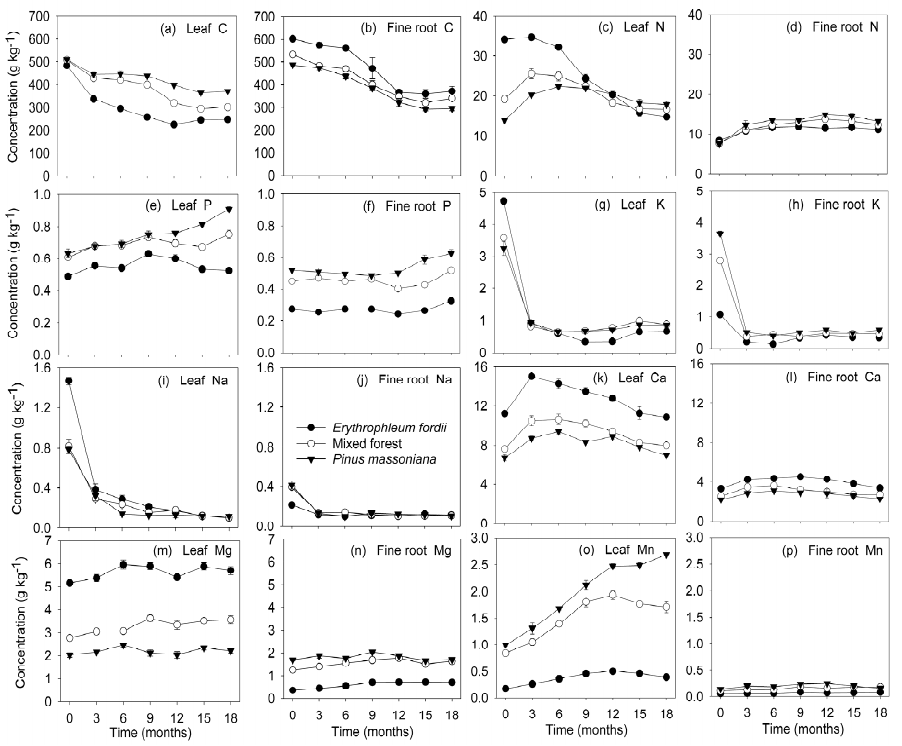
Figure 3. Nutrient concentration dynamics (mean ± standard error, n = 3) in leaf and fine root litter of three subtropical plantations in China.